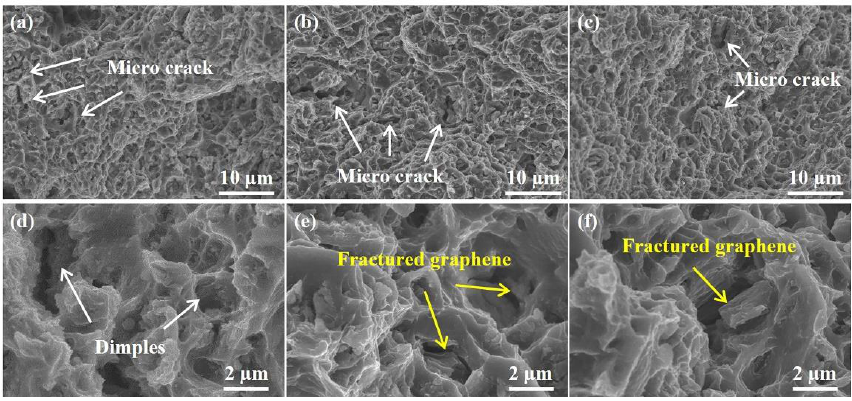
Figure 12. Tensile fracture morphologies of ( a , d ) ZK61 alloy, ( b , e ) 0.4 wt.% RGO/ZK61 composite and ( c , f ) 0.6 wt.% RGO/ZK61 composite. and ( c , f ) 0.6 wt.% RGO/ZK61